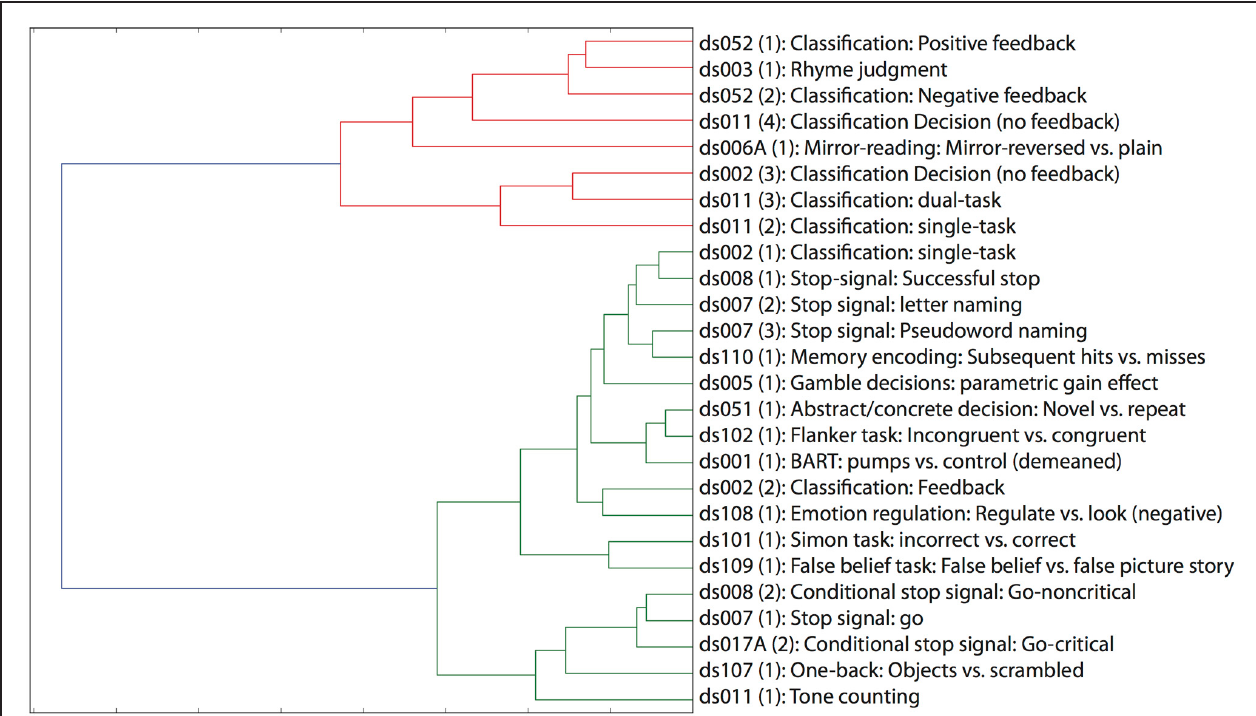
FIGURE 4 | Hierarchical clustering of statistical maps across tasks, after projection into the 20-dimensional ICA space depicted in Figure